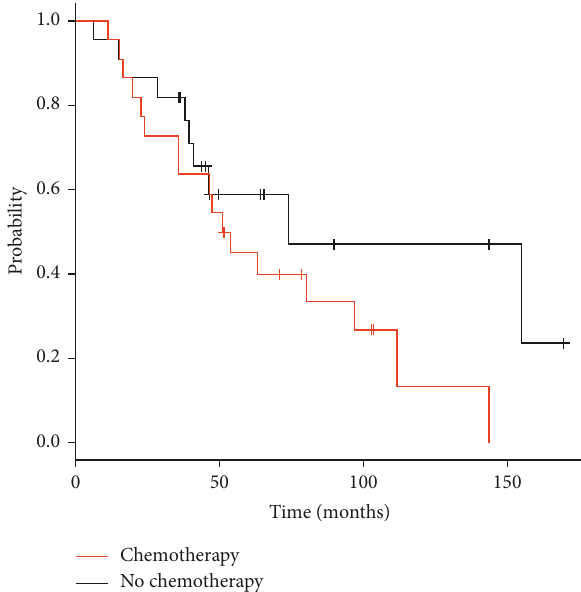
Figure 2: Actuarial overall survival from diagnosis in patients treated with and without chemotherapy.